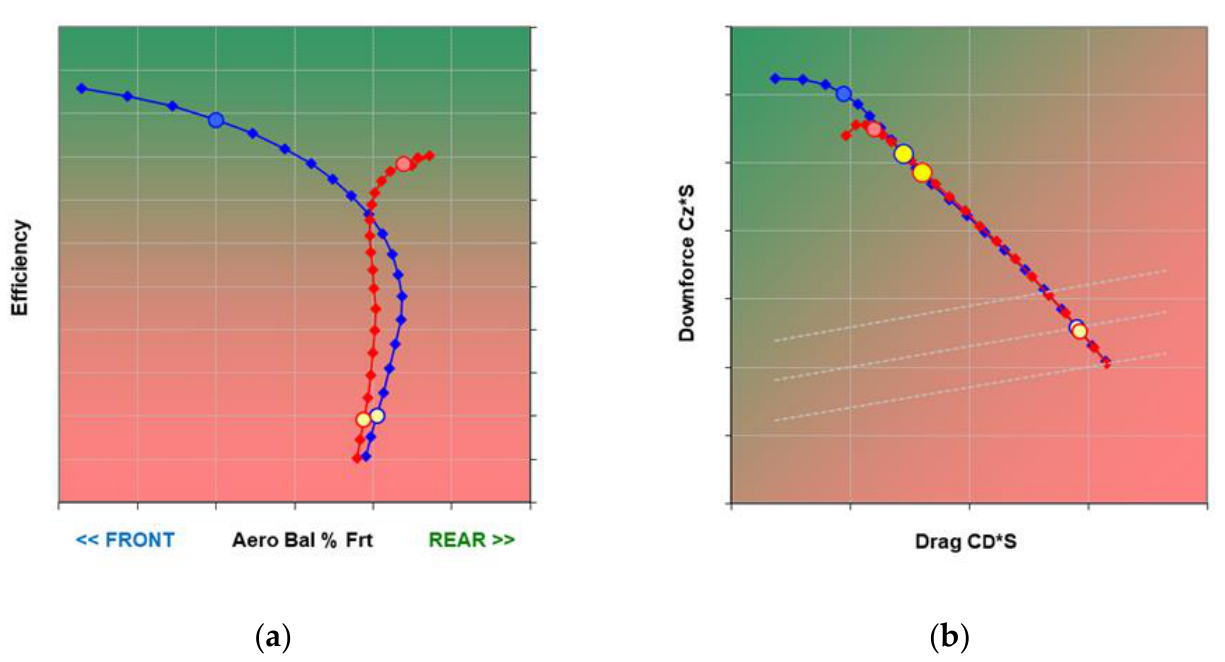
Figure 14. Front and rear decay functions starting from static ride heights: ( a ) RH vs. RH sensitivity; ( b ) FRH and RRH vs. Speed. Dots and lines as in Figure 11.